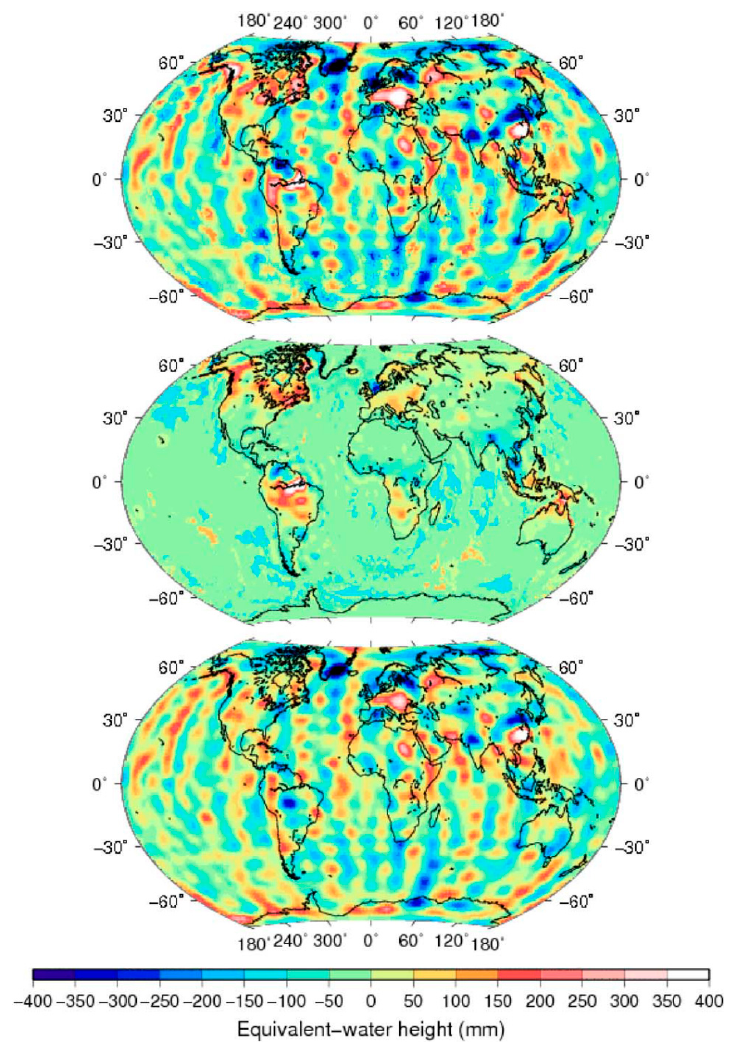
Figure 6. Synthetic GRACE-based anomaly of mass for March 2006 obtained combining ocean bottom pressure from the Estimating the Circulation and Climate of the Ocean (ECCO) model, TWS from WaterGAP Global Hydrology Model (WGHM) and north-south stripes obtained as the differences between level-1 and level-2 GRACE solutions (top). The application of a filter (here using the Independent Component Analysis) allows for the separation of the land and ocean signals (middle) from the north–south stripes (bottom). Source: [121].